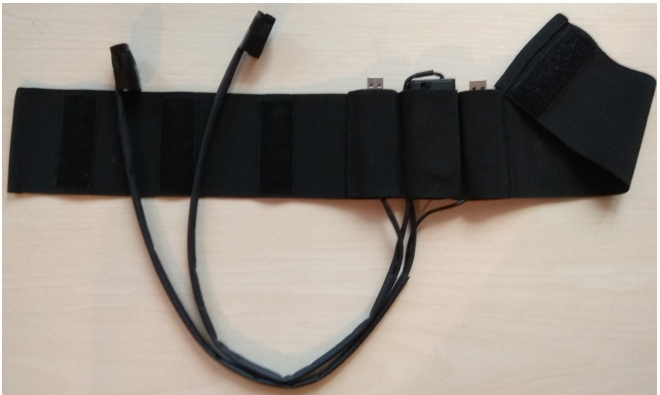
Figure 2. Constructed device. The elastic band was used for ensuring the exact placement of microphones on the skin. The device is designed and constructed so that it fits most people and it does not require